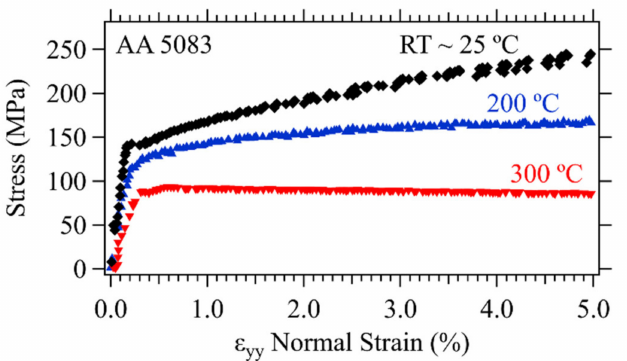
Figure 3. Stress–strain curves at different temperature conditions, representative cases. The reported strains were obtained from DIC full field averages as shown in Figure 2c.